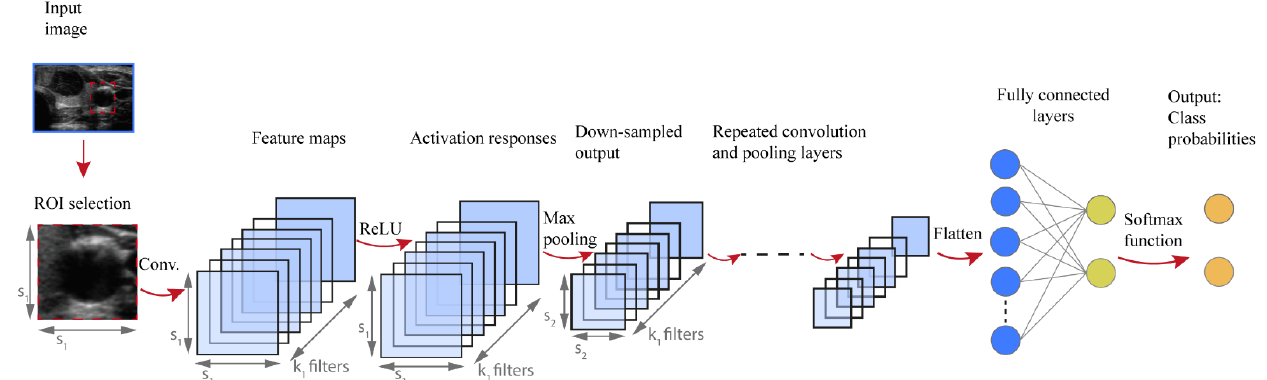
Figure 2. Schematic flowchart of the deep learning model implementation and application for medical images classifica- tion purposes.